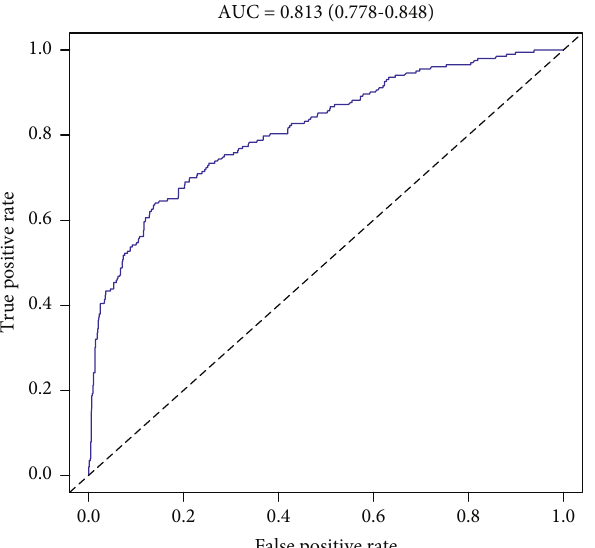
Figure 3: The AUC of the DN risk nomogram model. The x -axis represents the false positive rate of the risk prediction, while the y -axis represents the true-positive rate of the risk prediction. The blue line displays the performance of the